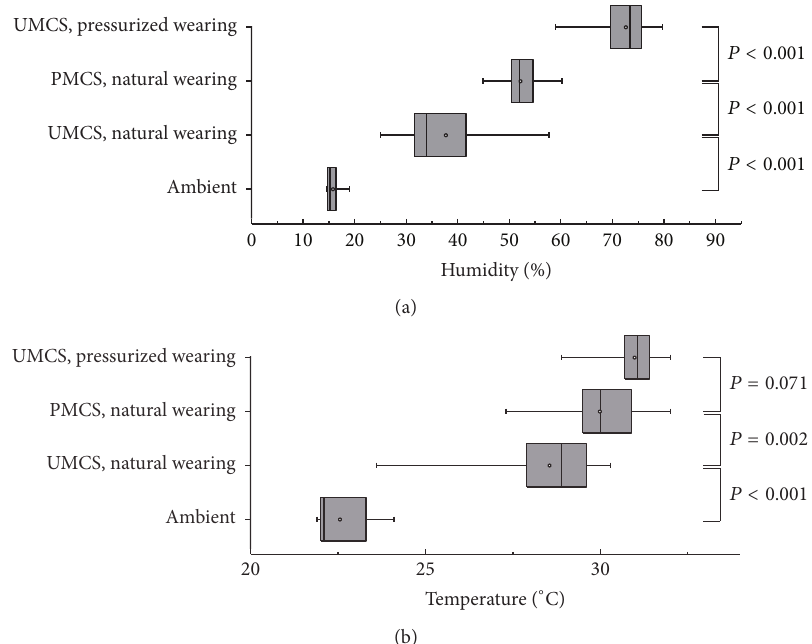
Figure 5: Comparisons of periocular humidity and temperature with various spectacles wearing. Box plots show minimum and maximum (whiskers), 25% and 75% quartiles (box), the median (line in the box), and mean (dot in the